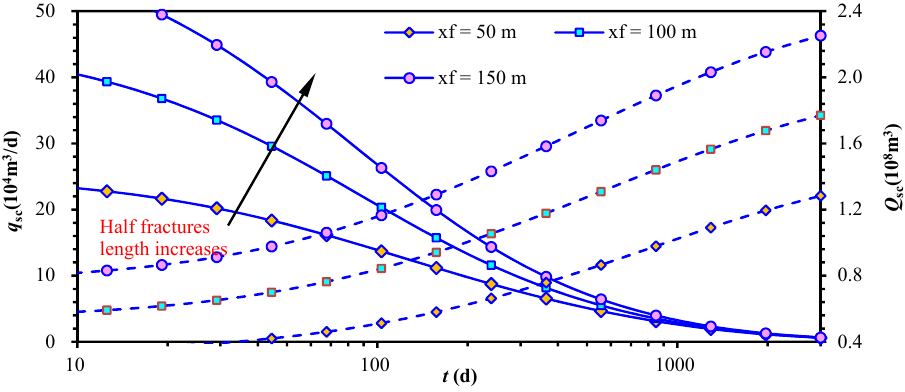
Figure 14. Effect of the fracture length on the production of shale gas reservoirs.